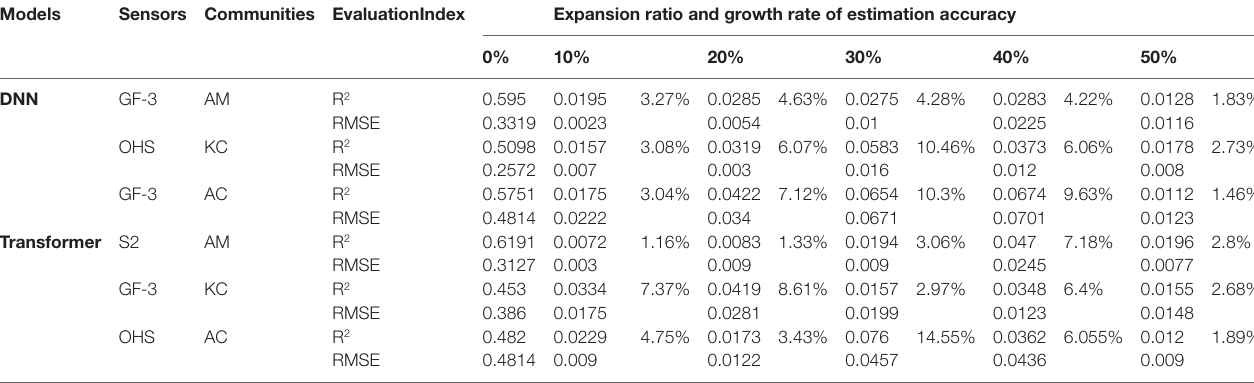
TABLE 6 | The LAI estimation accuracy of mangrove communities for the DNN and Transformer models with training sample extension. Models